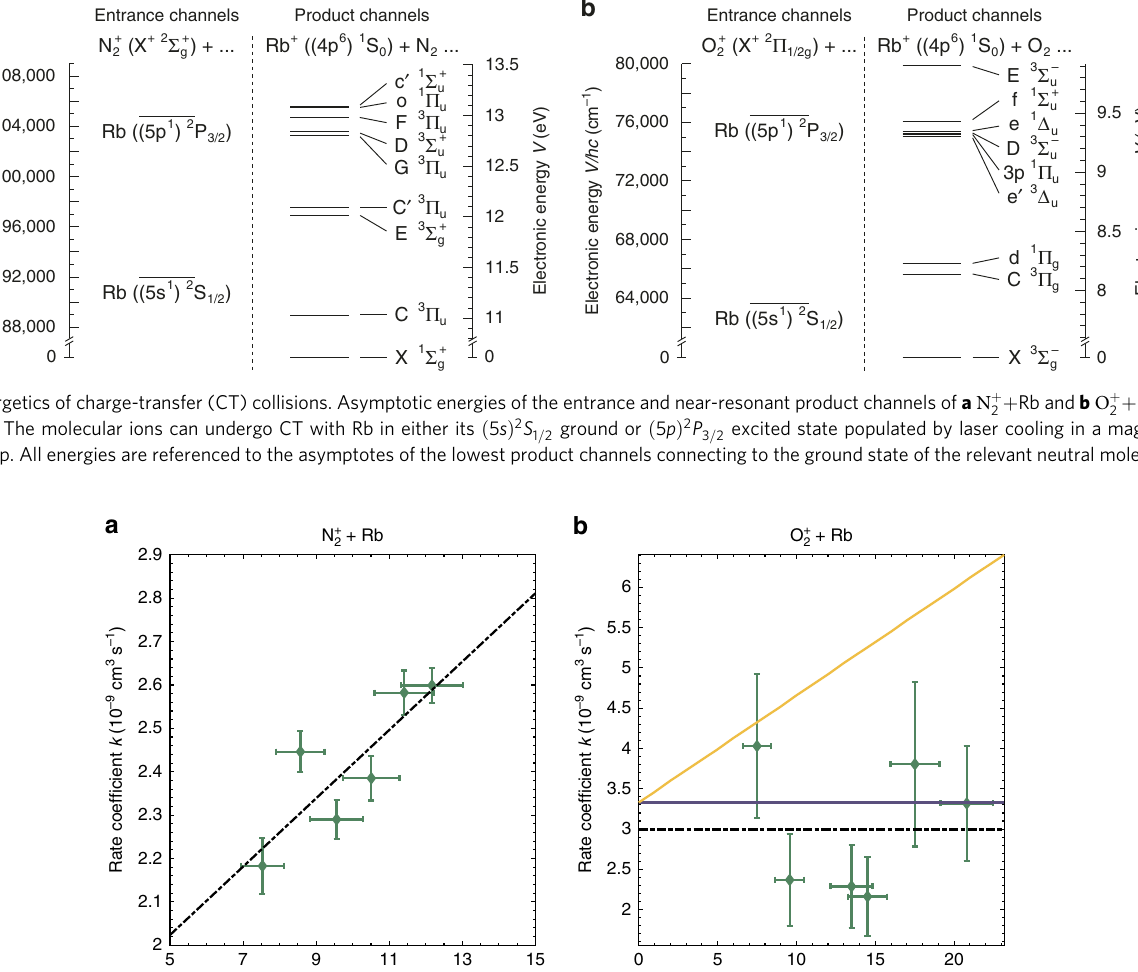
Fig. 2 State-averaged charge-transfer (CT) rate coef fi cients. Effective state-averaged CT reaction-rate coef fi cients as a function of Rb( 2 P 3 = 2 ) population for and b O þ . The black dash-dotted lines show linear fi ts to the experimental data (green symbols). The orange solid line in b is a prediction of the a N þ 2 2 + Rb assuming Langevin interactions in reactions with Rb 2 S effective rate coef fi cient for O þ 2 Rb 2 P 3 = 2 . The blue solid line indicates the theoretical Langevin rate coef fi cient for O þ